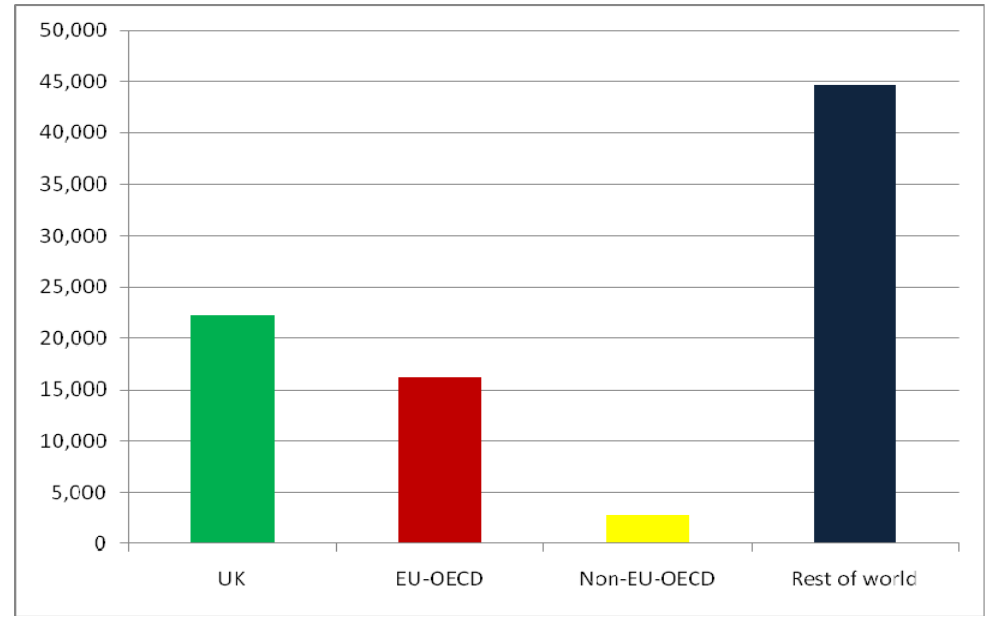
Figure 1. UK total water footprints divided by regions (million m 3 ).